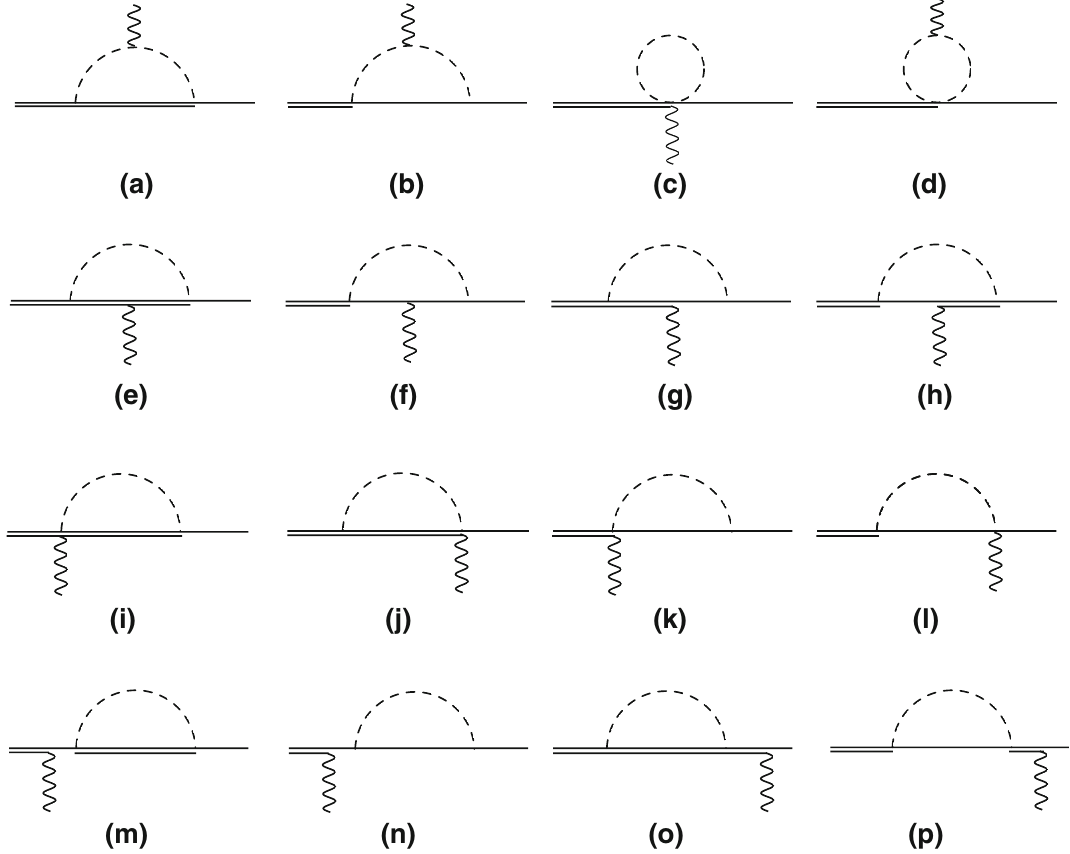
Fig. 2 The one-loop diagrams where the decuplet (octet) baryon is denoted by the double (single) solid line. The dashed and wiggly lines represent the pseudoscalar meson and photon respectively + G tree = G tree 2 G tree M 1 (cid:13) ∗ 0 → (cid:13) 0 γ M 1 (cid:13) ∗+ → (cid:13) + γ M 1 (cid:13) ∗− → (cid:13) − γ √ + = G tree G tree 3 G tree M 1 (cid:13) 0 M 1 (cid:15) 0 M 1